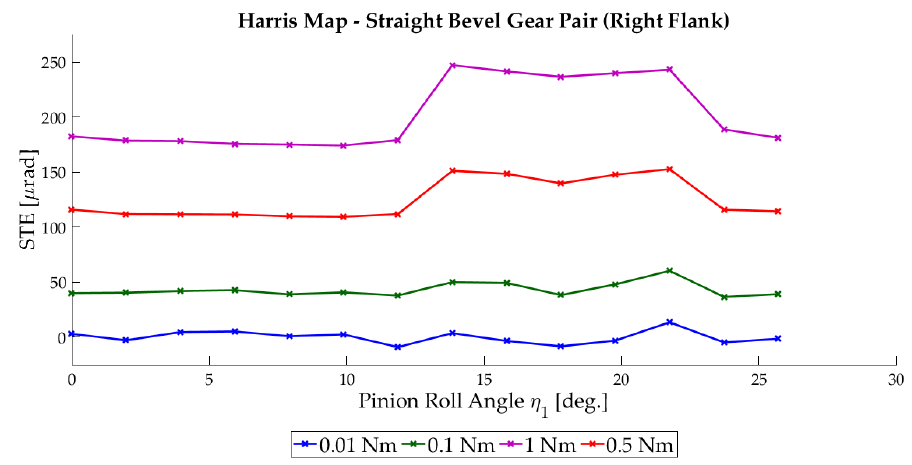
Figure 7. Static transmission error (STE) curves of the bevel gear pair under different loading conditions. Table 2. Calculated peak-to-peak values under different loading conditions.